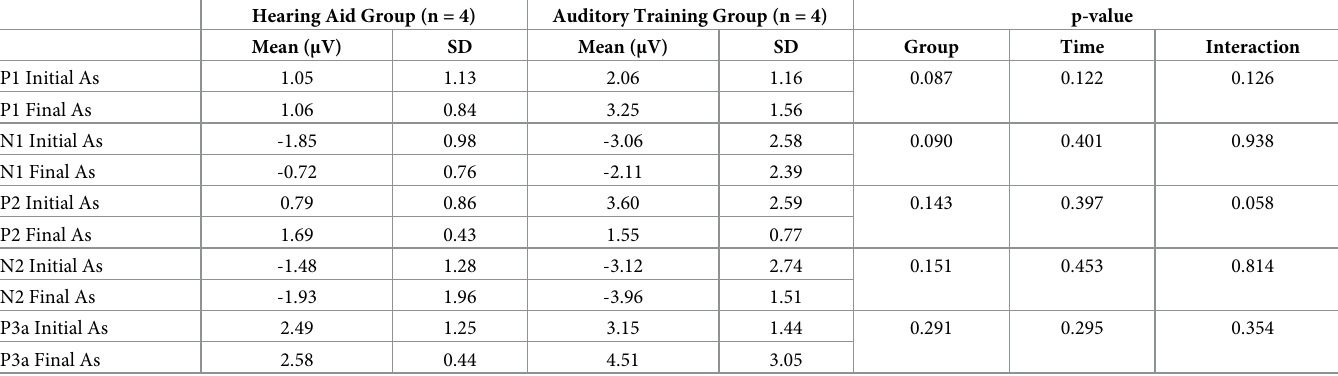
Table 5. Mean and standard deviation of the cortical auditory evoked potential amplitude values ( μ V) at the two assessed moments.